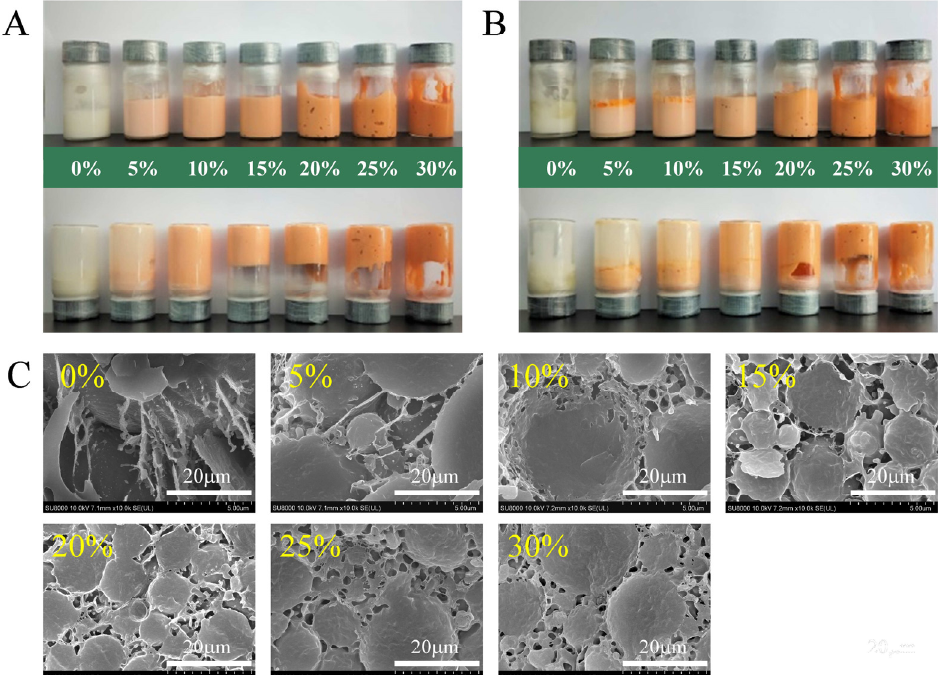
Figure 6. Visual observation of the HIPEs with different levels of Antarctic krill oil (AKO) (0, 5, 10, 15, 20, 25, and 30%, w/w ) at 4 °C for 7 d ( A ), 30 d ( B ), and the cryo-SEM morphology of the HIPEs after 30 d of storage ( C ). Scale bars, 5 µm.